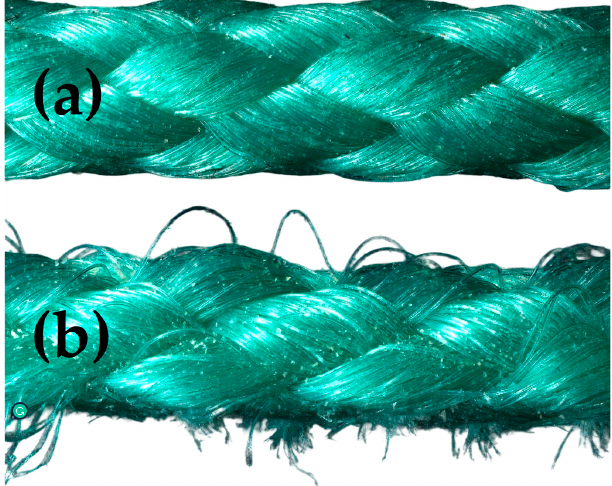
Figure 12. The condition of the traction wires before ( a ) and after the long-term test ( b ).